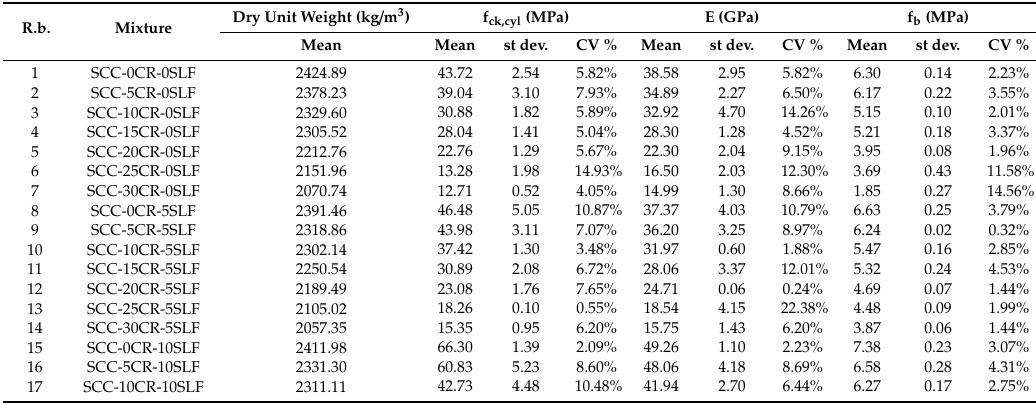
Table 7. Test results of hardened SCC